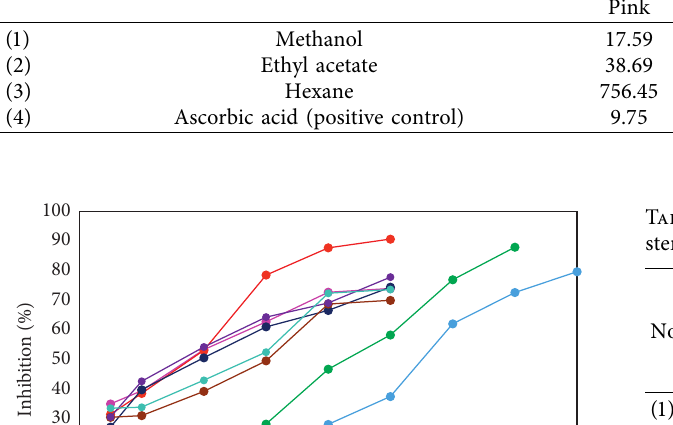
Table 3: Antioxidant activities 50 (IC No.